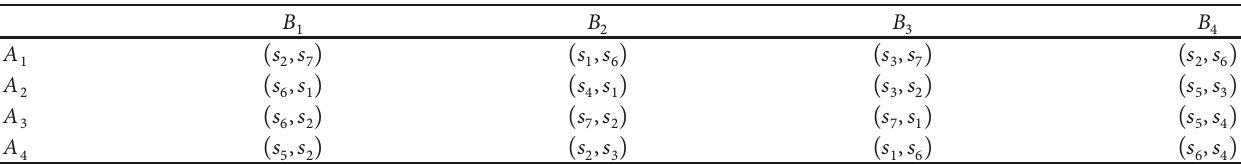
Table 5: The normalized linguistic Pythagorean fuzzy preference information matrix 𝑍 2 provided by the decision-maker 𝑀 2 . 𝐴 1 𝐴 3